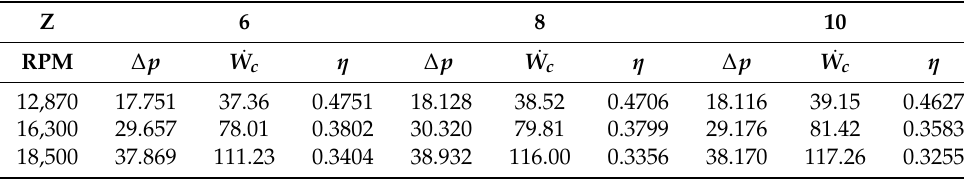
Table 10. Number of blades sensitivity analysis.